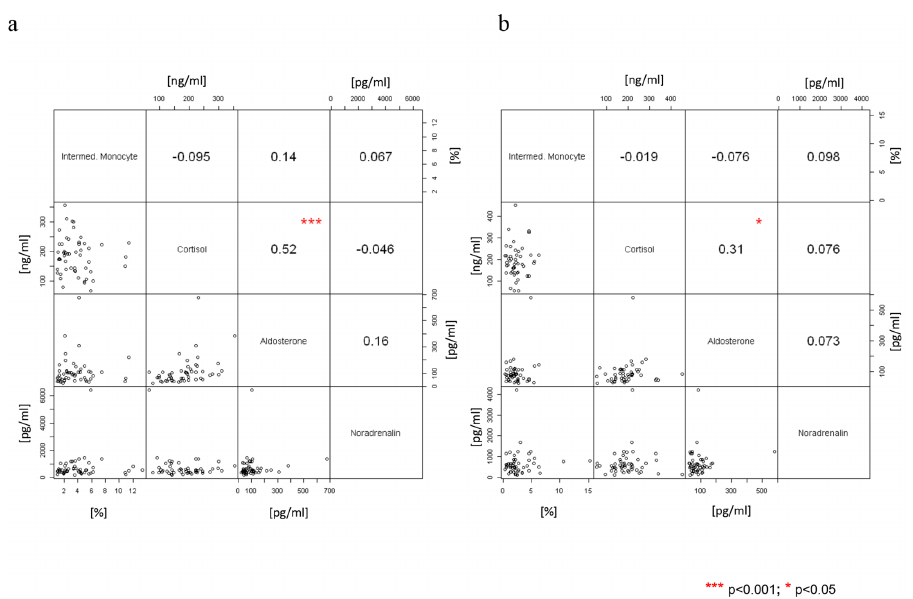
Fig 5. Correlations of intermediate monocytes with cortisol, aldosterone and noradrenaline. Correlations (Spearman)betweenintermediate monocyte measuredby flow cytometry and cortisol (cor), aldosterone (aldo) as well as noradrenaline (nor). (a) Intermediate monocyte pre TAVR vs. cor, aldo, nor pre TAVR. (b) Intermediate monocyte post TAVR vs. cor, aldo, nor post TAVR. Correlationsamong cor, aldo and nor are also shown. On the top of each graph: pairwisecorrelationvalue and relative significance(negative value indicatesinverse correlation); on bottom: bivariate scatterplot. ** p < 0.01.